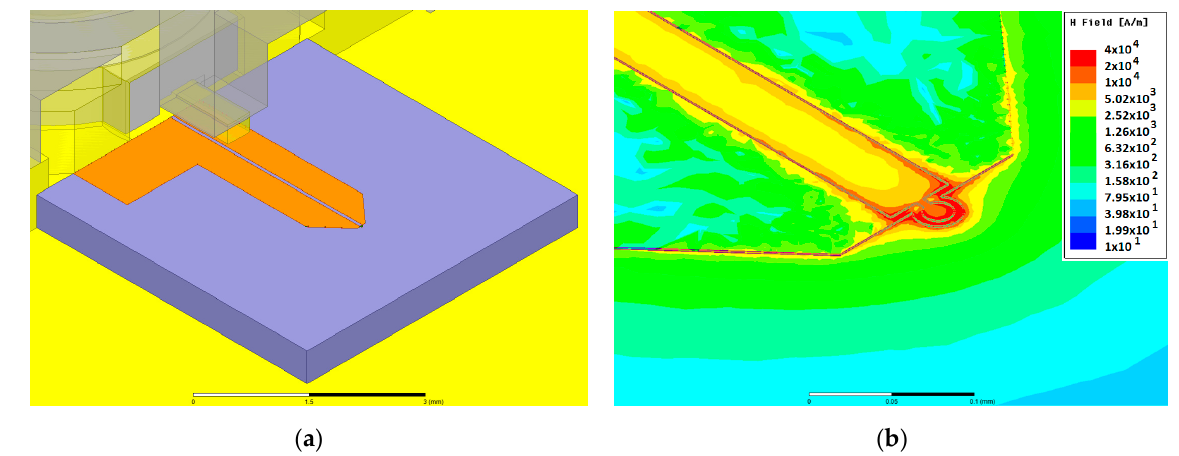
Figure 1. Layout ( a ) and magnetic microwave field ( b ) distribution of the microantenna, obtained by FEM simulation of the structure.